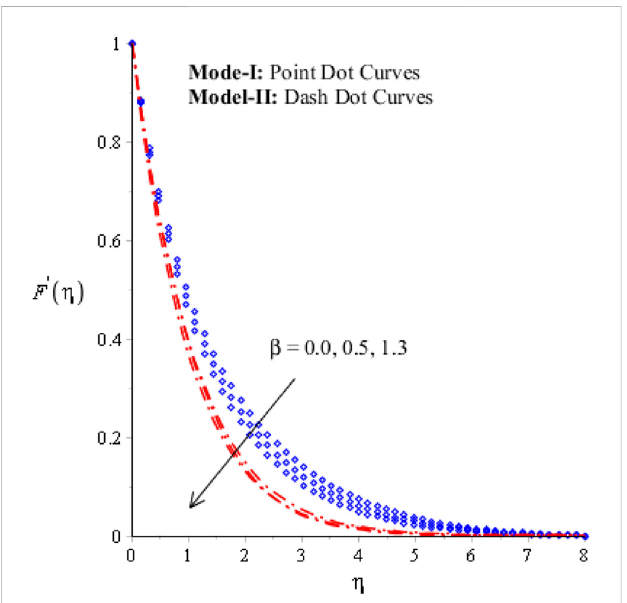
FIGURE 5 Effect of H t on temperature curves when α (cid:2) 0 . 6 , n (cid:2) 0 . 4 , Re (cid:2)